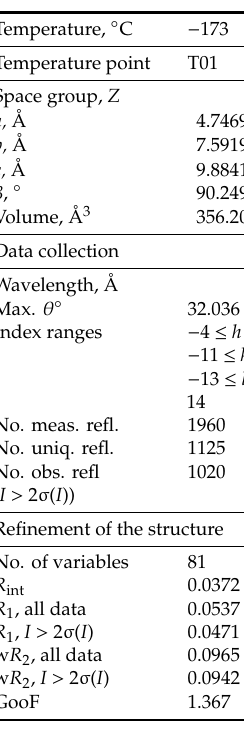
Table 2. Crystallographic data and refinement parameters for